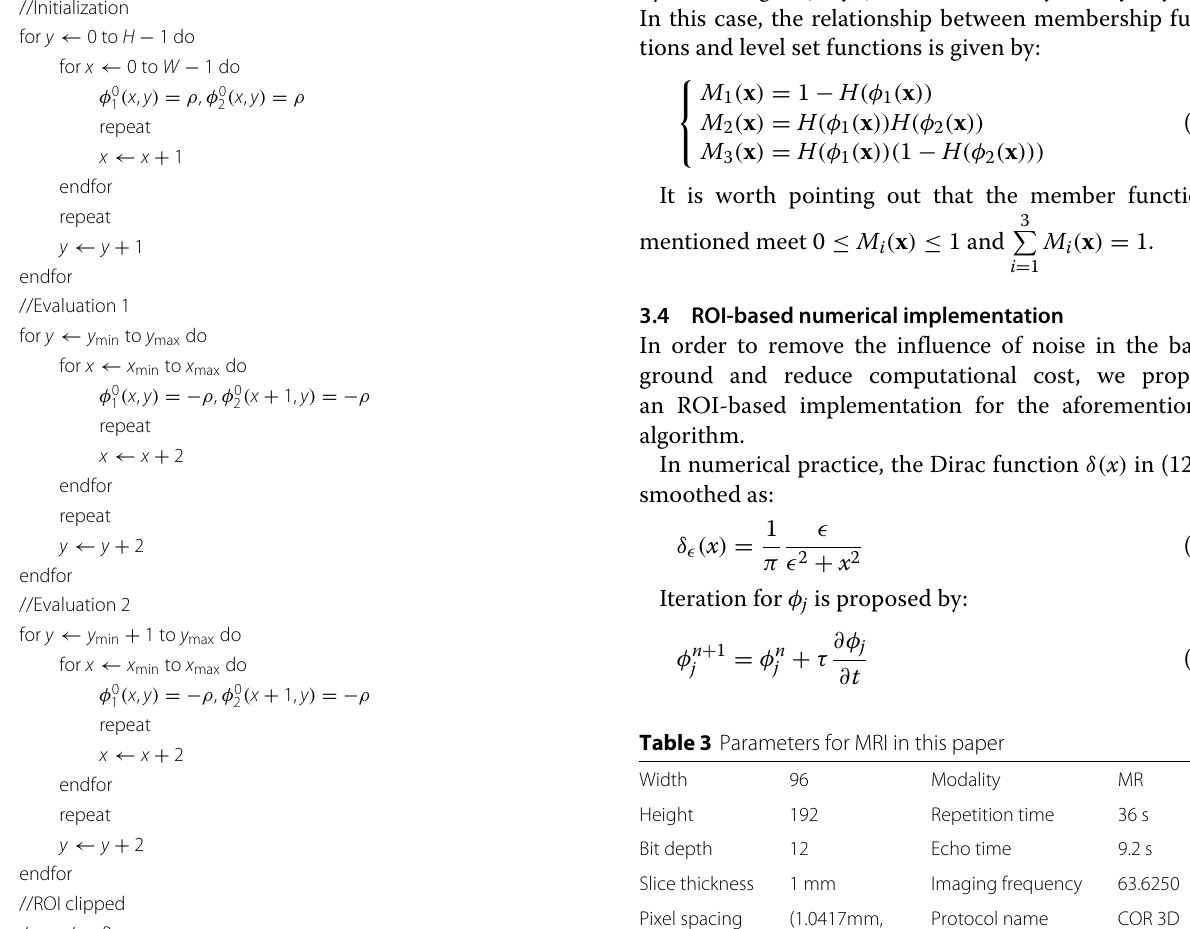
Table 2 Definition of φ 0